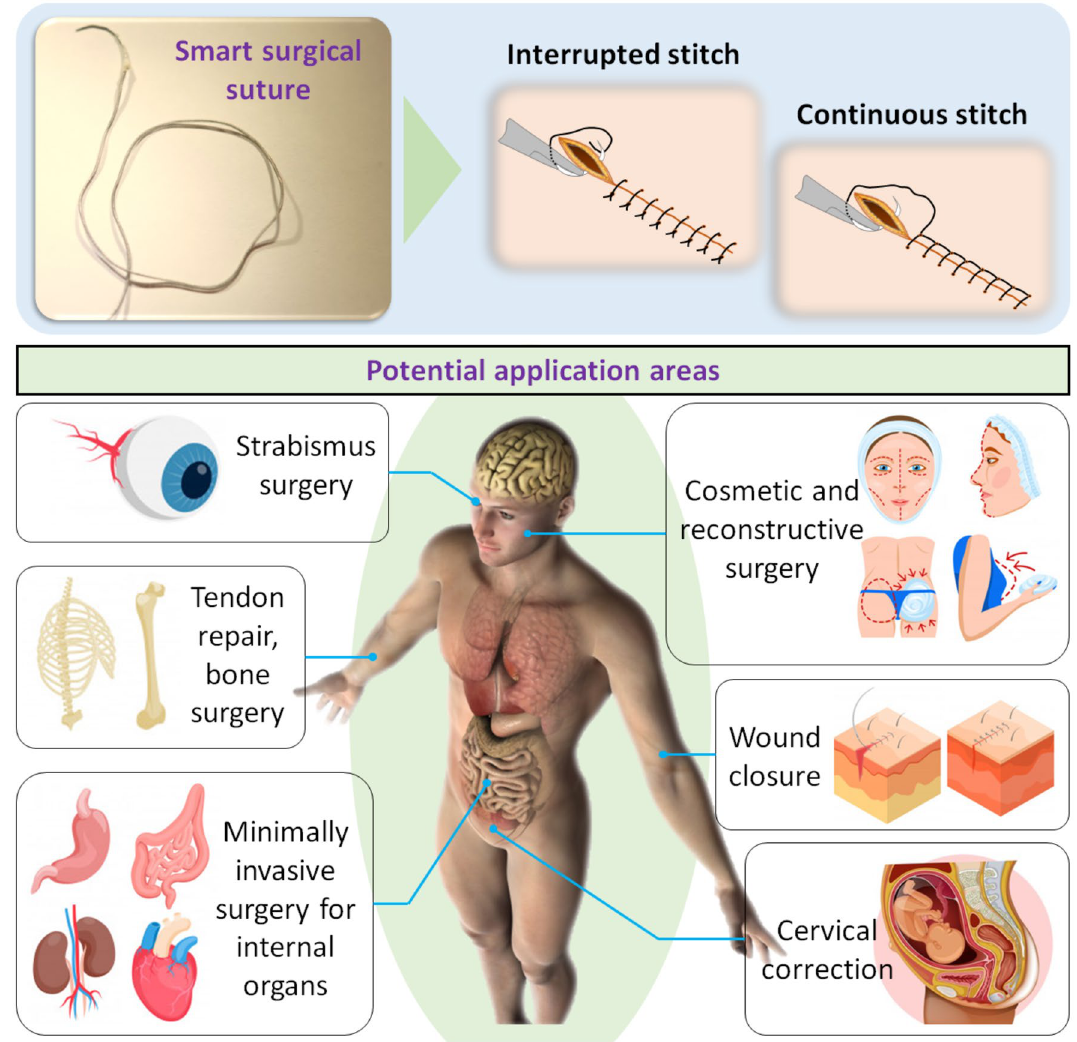
Figure 1. Smart surgical suture with two typical surgical stitches and their potential application areas. The pictures of strabismus surgery, tendon repair, bone surgery, minimally invasive surgery for internal organs, cosmetic and reconstructive surgery, wound closure, and cervical corrections were “Designed by